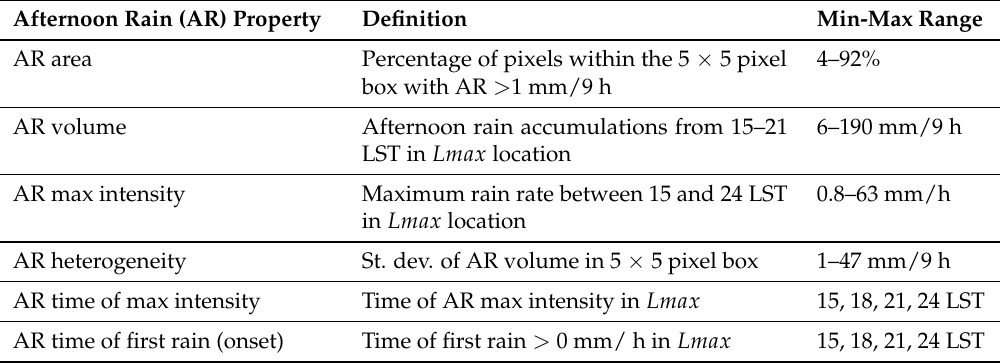
Table 2. Definitions of Afternoon Rain (AR) properties. The minimum-maximum range of every AR property within our final sample of 15,790 events estimated based on the TRMM-3B42 precipitation dataset is also